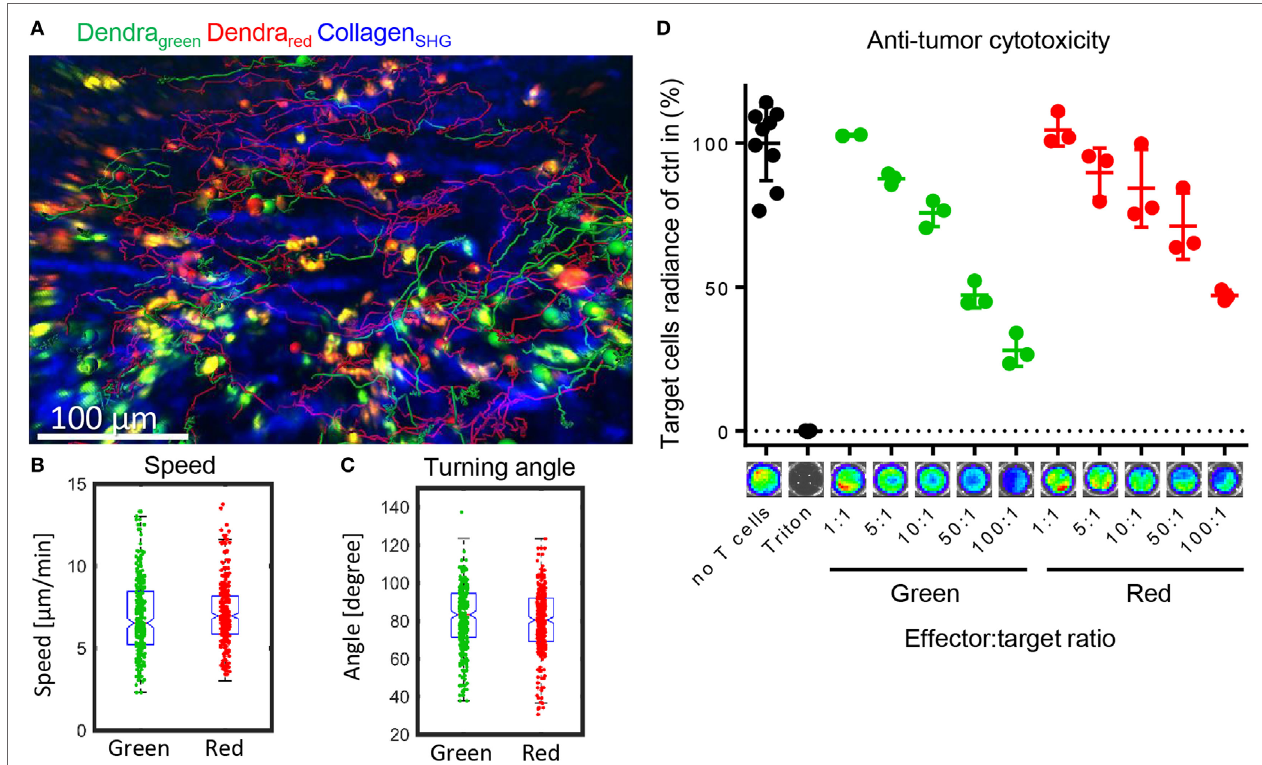
FIGUrE 5 | Photoconverted T cells migrate physiologically in the target organ small intestine. (A) Representative tracks of green and red Dendra2 + T cells in the lamina propria of the small intestine, a graft-versus-host disease target organ. Data were collected with intravital two-photon microscopy. (b) Similar migration speed as a basic measure of motility and (c) similar turning angles as a basic measure of directionality (both Student’s t -test: ns) in green and red cells in the lamina propria ( n = 266 green and 419 red cells). (D) Cytotoxicity assay measuring Luciferase activity of target BALB/c tumor cells. Allogenically stimulated Dendra2 + cells were photoconverted or not and then co-incubated with target cells for 6 h. Red and green cells lysed to a similar extend ( n = 3, Dunn’s multiple comparisons test: